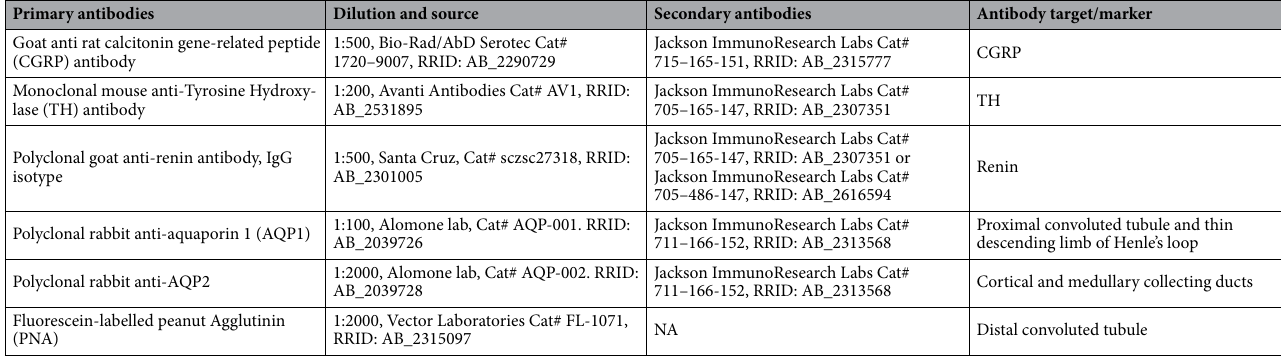
Table 5. Primary and secondary antibodies used for kidney